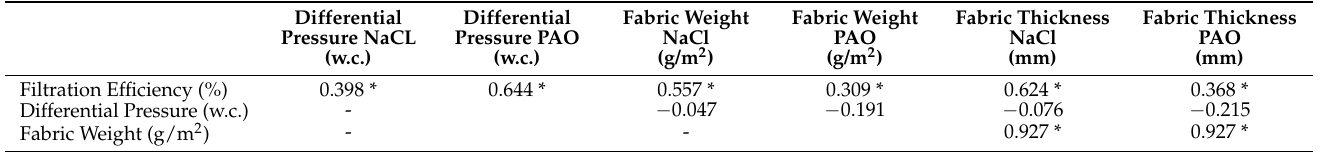
Table 3. Pearson Correlation Values between Measures when Using NaCl